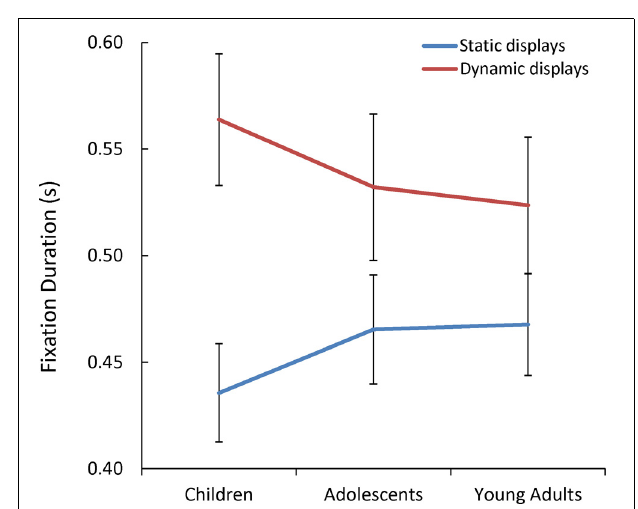
FIGURE 5 | The mean fixation duration(s) while children, adolescents, and young adults viewed each static and dynamic